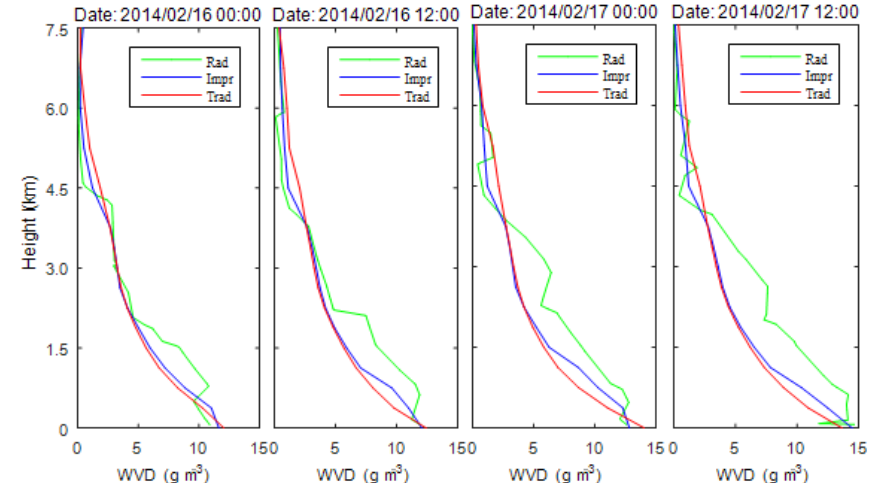
Figure 6. Comparisons of water vapor densities (WVDs) obtained from tomography and radiosonde on 16–17 February 2014. “Rad” repre- sents the radiosonde-derived water vapor density. “Impr” represents the tomography-derived water vapor density using our optimized method, and “Trad” represents the tomography-derived water vapor density using the traditional method.